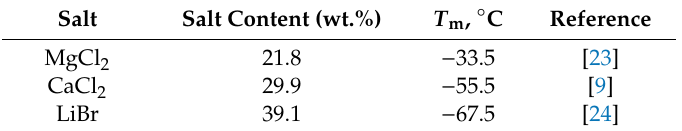
Table 2. Salt content in the selected “water and salt” eutectic solutions and their melting temperature T m .